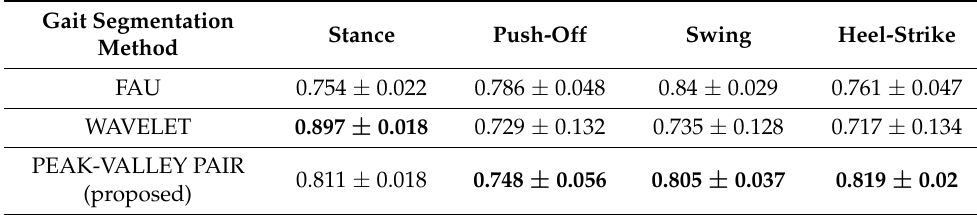
Table 4. Gait segmentation results for different methods in F-score values. Best results for each speed group are highlighted in bold numbers.